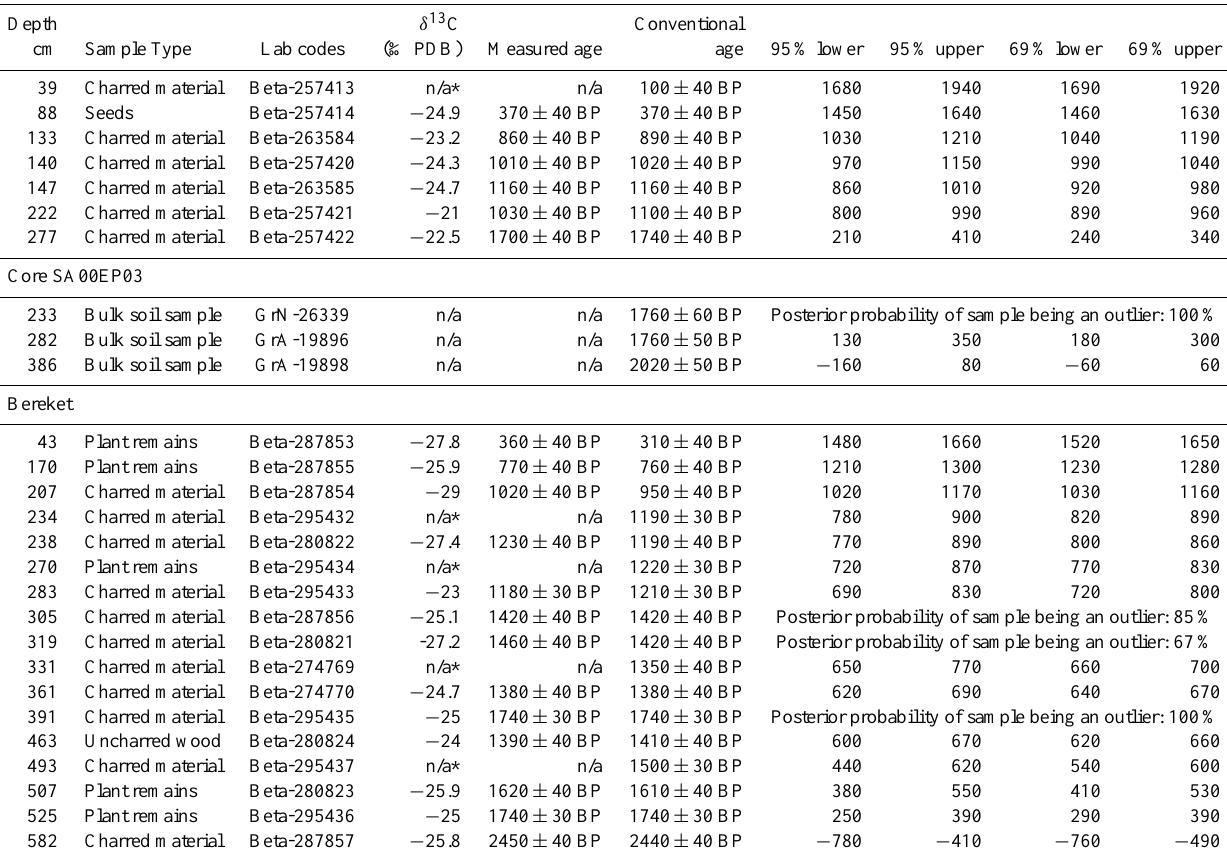
Table 3. List of AMS 14 C ages from charcoal samples from core SA06EP1 (Gravgaz Marsh), and core SA09JBDrill01 (Bereket Basin). Ages are calibrated using the IntCal09 calibration curve. Calibrated ages are given as 1 sigma and 2 sigma probabilities, using the BCal online software package (Buck et al., 1999). The age-depth relationship of the Gravgaz marsh core is augmented by the four topmost radiocarbon ages from core SA00EP03, collected on the same